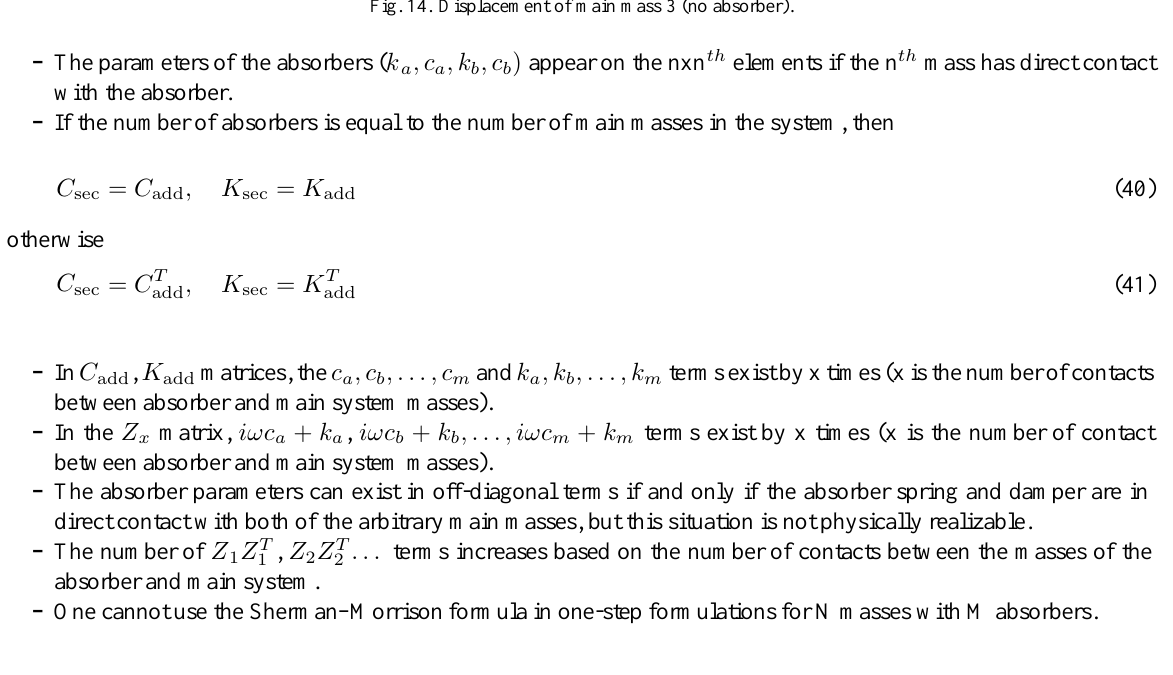
Fig. 14. Displacement of main mass 3 (no